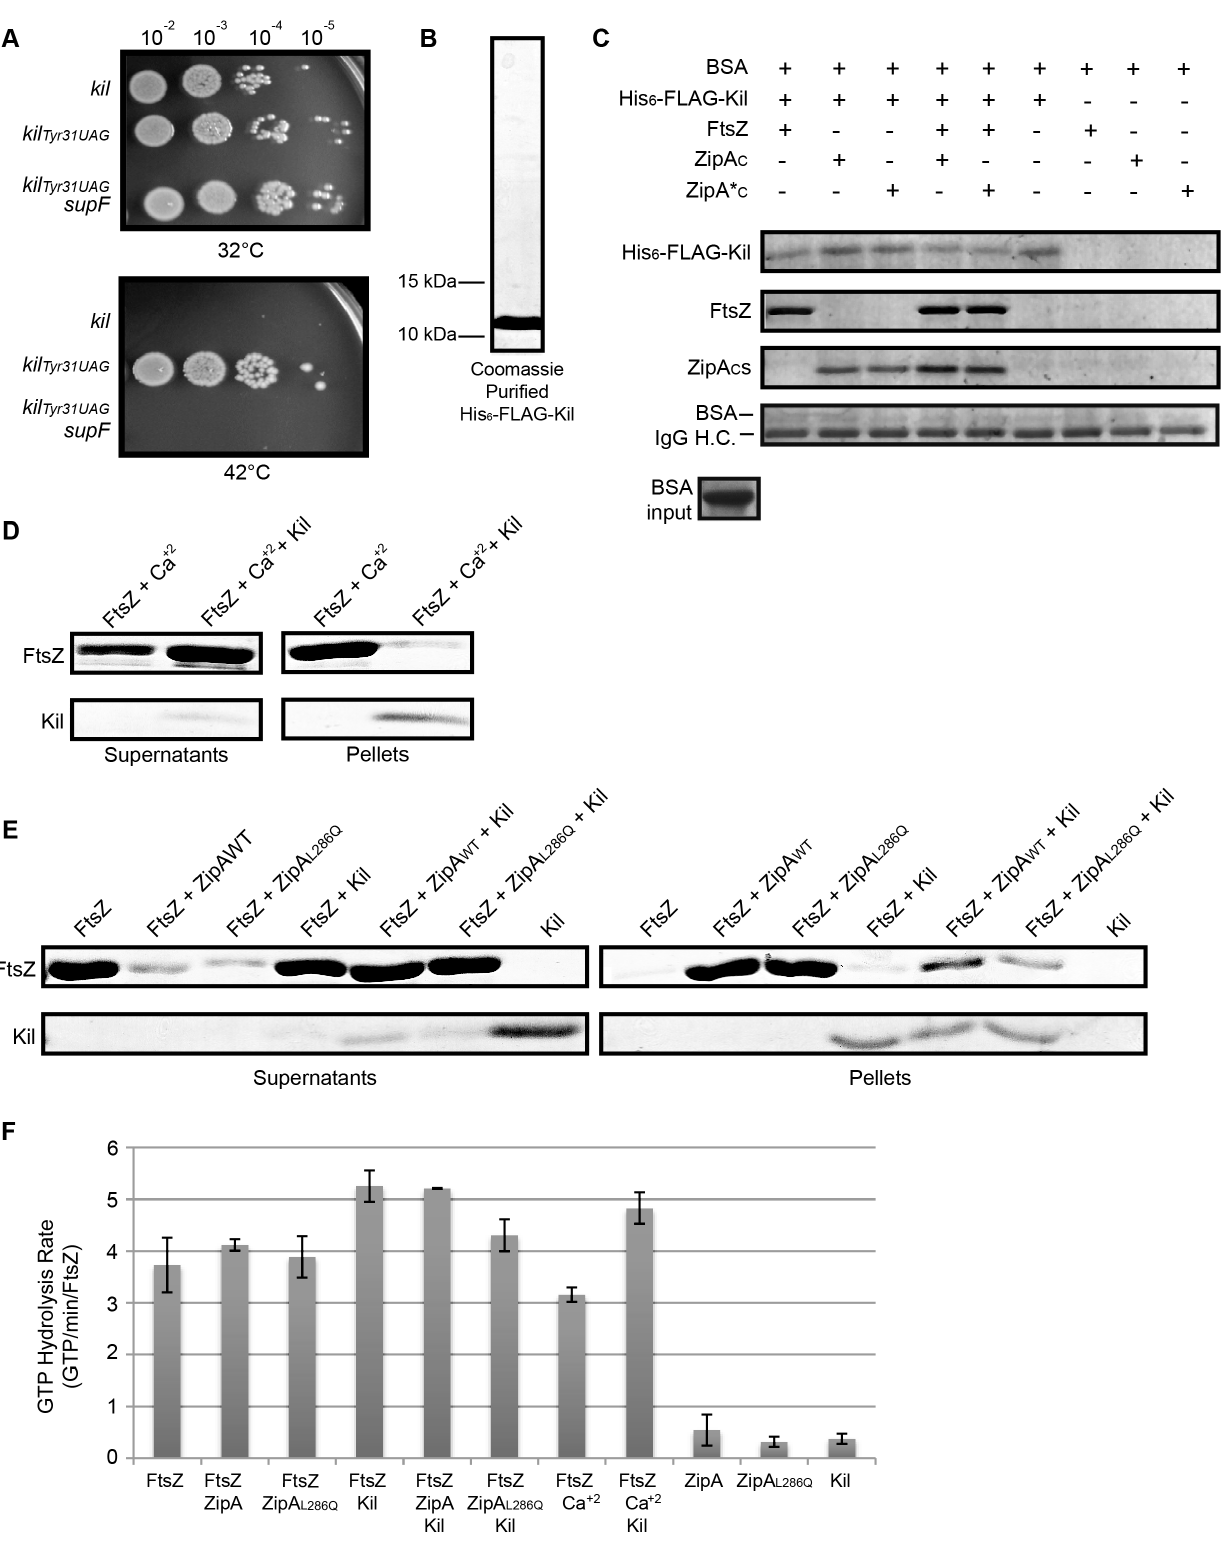
Figure 8. Kil protein copurifies with FtsZ and ZipA and inhibits FtsZ bundling invitro . (A) The product of the kil gene is a protein. Spot dilutions incubated at 32 or 42 u C of cells containing, under P L control, a wild type copy of kil (top row), a copy of kil where the thirty-first codon is replaced with an amber stop codon (middle row), or cells of an isogenic strain containing the supF gene that allows translation through the amber stop codon (bottom row). (B) His 6 -FLAG-Kil purifies as a single, intense band from BL21(DE3) ftsA R286W D zipA::aph pBS58 cells. Shown is a Coomassie- stained 20% acrylamide SDS gel loaded with 15 m L purified His 6 -FLAG-Kil, with location of indicated size makers noted. (C) His 6 -FLAG-Kil interacts with